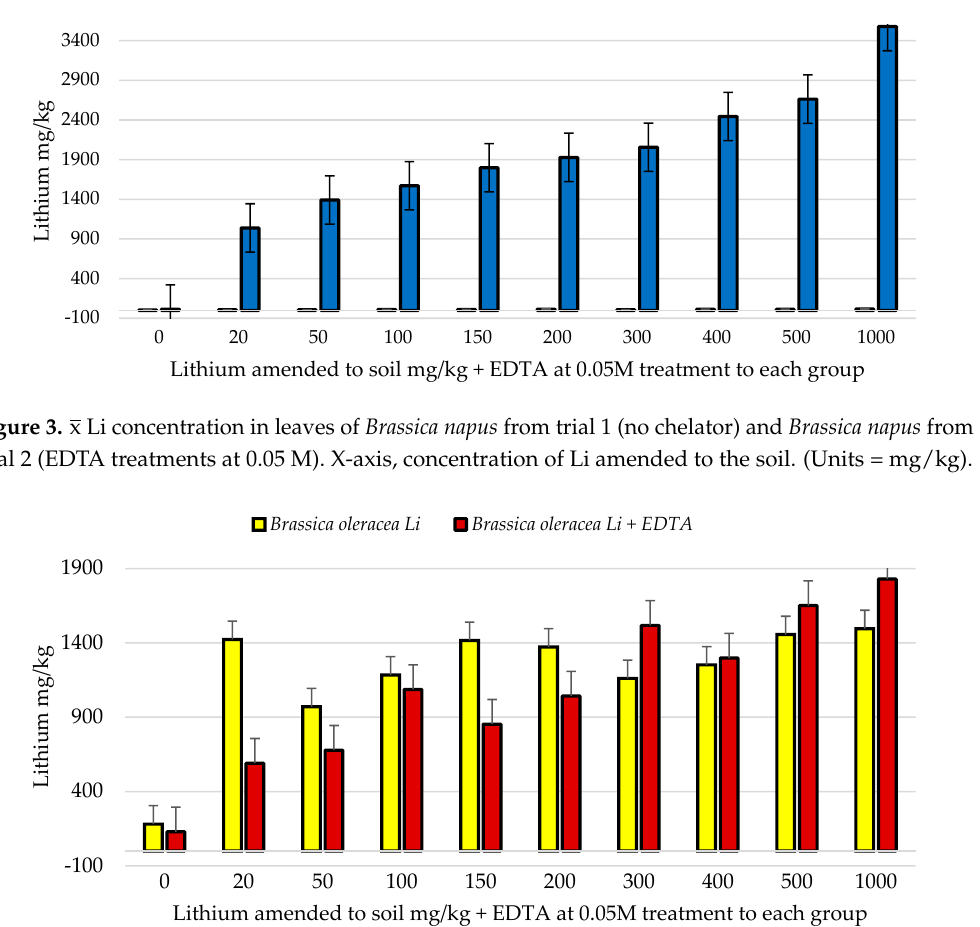
Figure 4. x ̅ Li concentration in leaves of Brassica oleracea from trial 1 (no chelator) and Brassica oleracea from trial 2 (EDTA treatments at 0.05M). X-axis, concentration of Li amended to the soil. (Units = mg/kg).